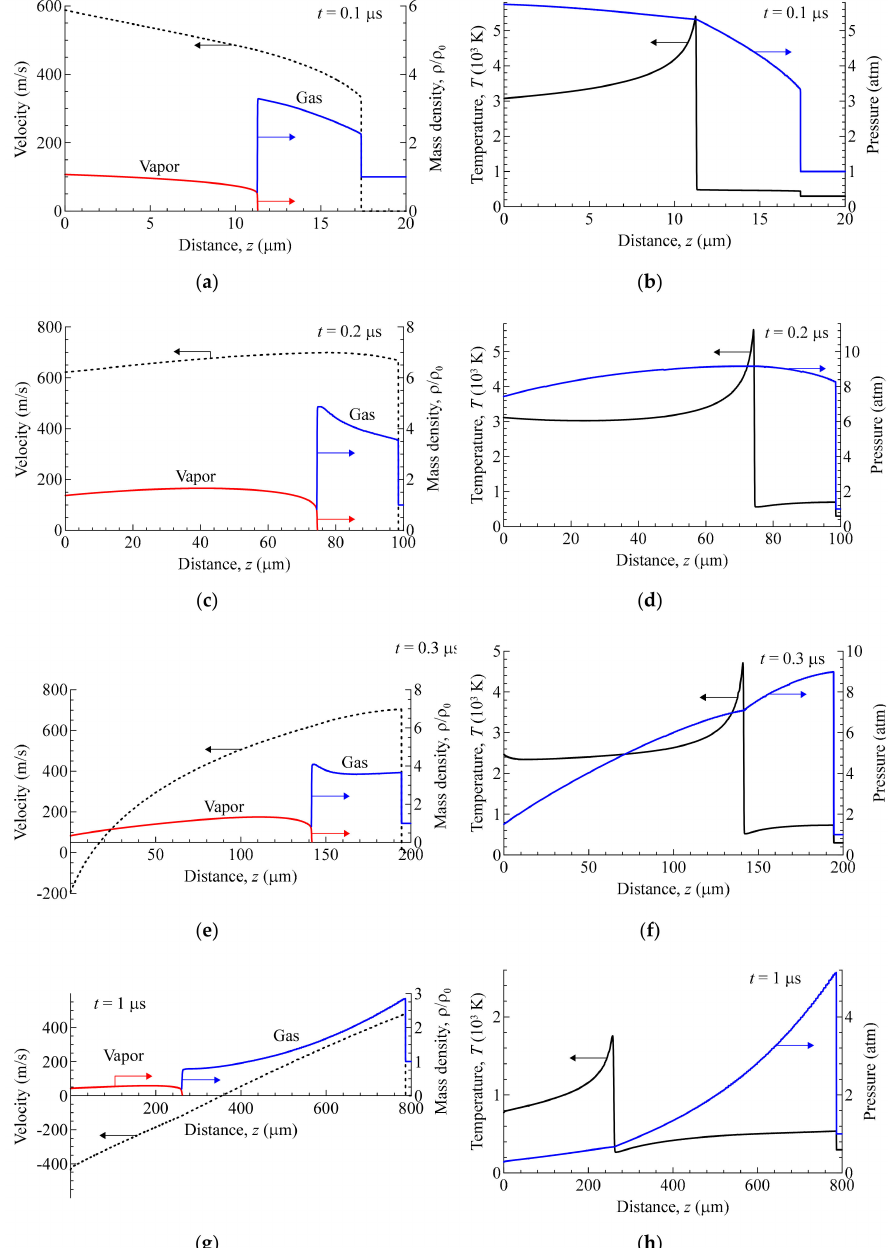
Figure 4. Evolution of the gas-dynamic fields at single-pulse laser processing with I max = 15 MW / cm 2 . The arrow near each curve points to the corresponding axis. The axis title contains the name of the physical quantity. Flow velocity (dashed curves) and mass densities of vapor (red curves) and gas (blue curves): ( a , c , e , g ). Temperature (black curves) and pressure (blue curves): ( b , d , f , h ). Time t : 0.1 µ s ( a , b ); 0.2 µ s ( c , d ); 0.3 µ s ( e , f ); 1 µ s ( g , h